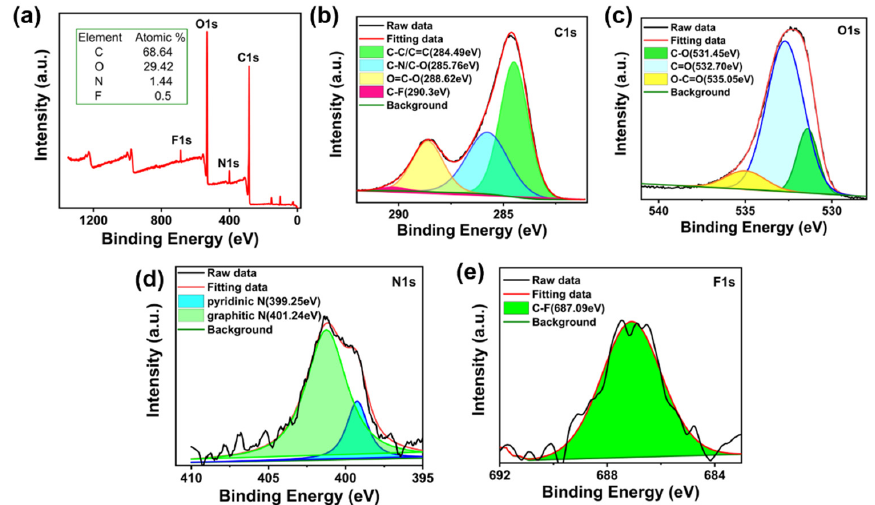
Figure 2. The XPS survey of NFCDs: ( a ) The full survey XPS spectrum of NFCDs presented the presence of C, N, O, and F elements. ( b – e ) The splitting of high-resolution C1s, O1s, N1s, and F1s confirmed the presence of surface functional groups observed in the FT-IR spectrum.